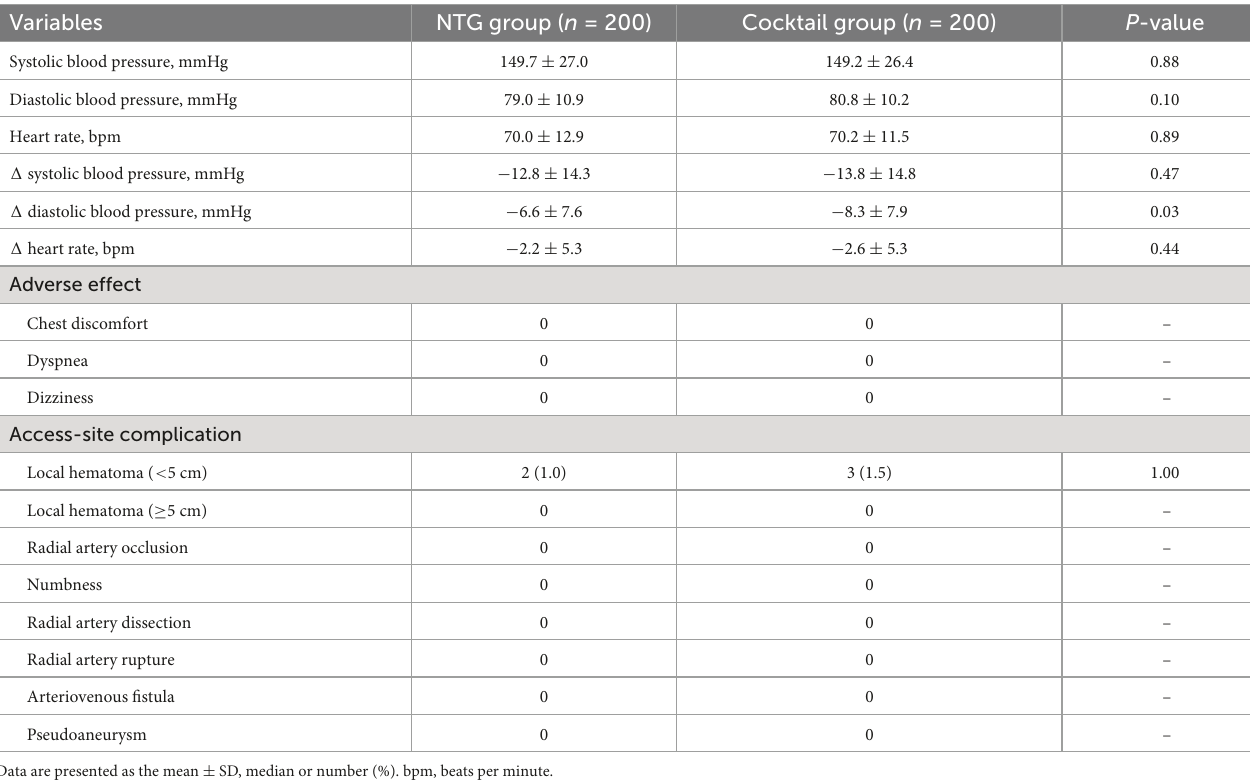
TABLE 4 Safety outcomes.